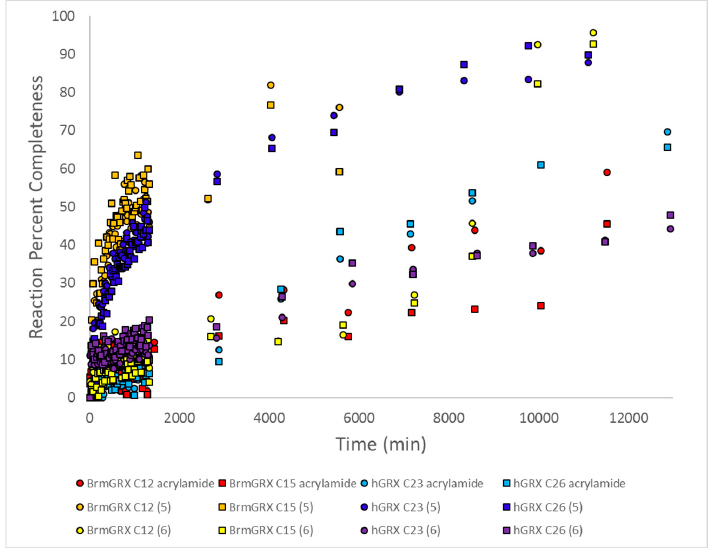
Figure 11. NMR signal-broadening-based kinetic studies for compounds 5 and 6 vs. naked acrylamide. Signal intensity of active site cysteine peaks are normalized to hydrophobic core signals using equation (2) to correct for aggregation and the loss in signal over time is monitored as a quantitative determination of the rate of reaction. The rate was very slow for naked acrylamide and displayed a reaction half life of about 20 h for both proteins. Modifying the ester form of RK207 with an acrylamide warhead (compound 5 ) enhances the rate of reaction by about 35 fold for both proteins with a slightly faster rate for BrmGRX. The non-ester form (compound 6 ) displays a rate comparable to naked acrylamide. The probable explanation for this is not only the carboxylic group, but also that the RK207 fragment scaffold plays some role in selectivity and is conserving this selectivity in the lead molecule. Compound 6 was found to have a rate very similar to plain acrylamide. Unfortunately, the inclusion of this acid form driving group makes compound 6 less reactive towards BrmGRX, as suggested by the kinetic plot in Figure 11. The reaction half time of this warhead compound for both BrmGRX and hGRX was similar to plain acrylamide. These data suggest that the inclusion of the acid group in compound 7 does not help compound 8 in increasing reactivity with BrmGRX. These results were partially corroborated by the bis(2-hydroxyethyl) disulfide (HED) biological assay, where some enhanced inhibition for lead compounds 5 and 6 were observed versus naked acrylamide (Figure S23). The HED assay is a classical assay for GRXs that measures GRX deglutathionylation activity by observing NADPH consumption at 340 nm in a reaction that couples GRX and glutathione reductase. During a preincubation phase GSH and HEDS spontaneously react to form a heterodisulfide. When GRX is introduced it catalyzes deglutathionylation of this disulfide, producing oxidized GSH. As quickly as it is made oxidized GSH is in turn reduced by glutathione reductase which consumes NADPH in a redox reaction [48]. In our hands the HED assay does not give completely reproducible activity with the warhead reaction and we found the concentration of compounds needed to be increased to observe inhibition at a time scale suggested by NMR broadening experiments. This could mean that broadening exhibited in the NMR kinetic experiments is not completely dependent on a covalent reaction and that reduction in active site Cys signal intensity is